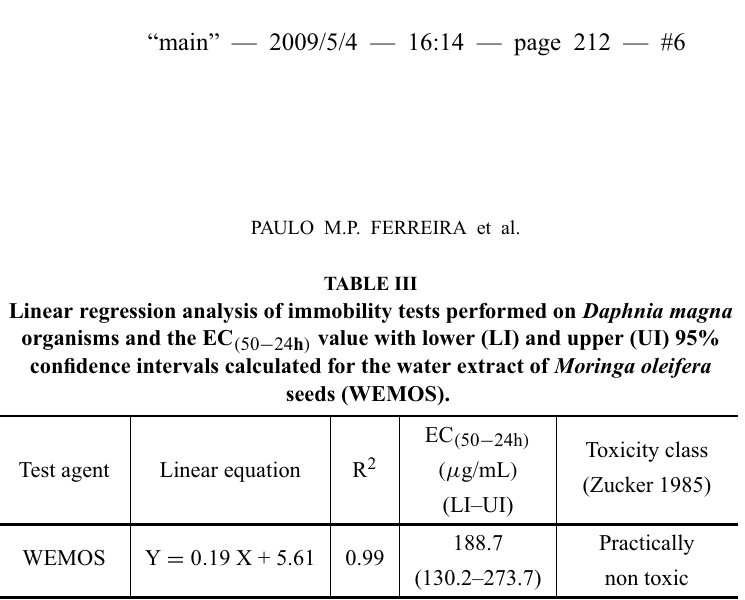
Hepatic enzyme activity of aspartate aminotransferase (AST), alanine aminotransferase (ALT) and alkaline phosphatase (ALP) after the oral treatment of rats with water extract of Moringa oleifera seeds (WEMOS) ad libitum during 30 days. Control group received tap water.